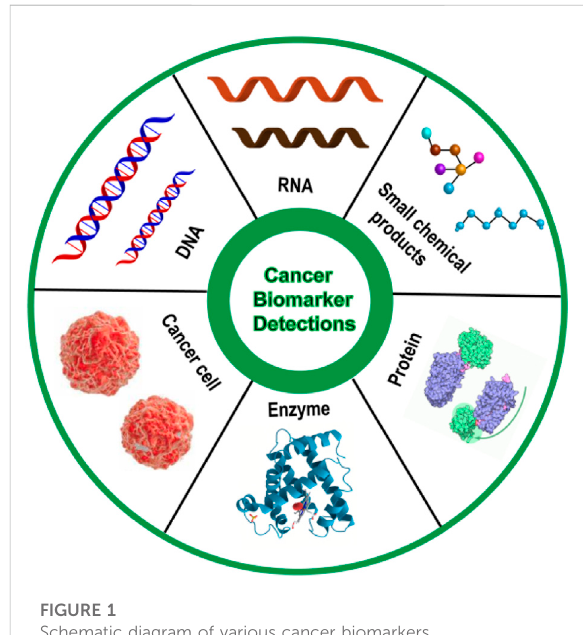
FIGURE 1 Schematic diagram of various cancer biomarkers.